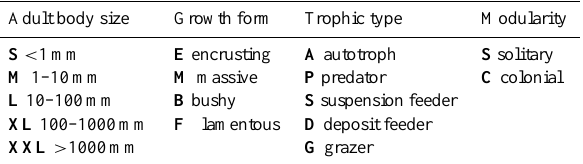
Table 2. Functional traits used for grouping. The metrics used are considered ecologically relevant and they can be surrogates for other traits. Thus, body size correlates closely with longevity or metabolic rate, growth form determines the species’ strategy for exploiting resources such as substratum or light, etc. Ecosystem services associated with these and similar traits are discussed in Bremner et al. (2006) and Wahl